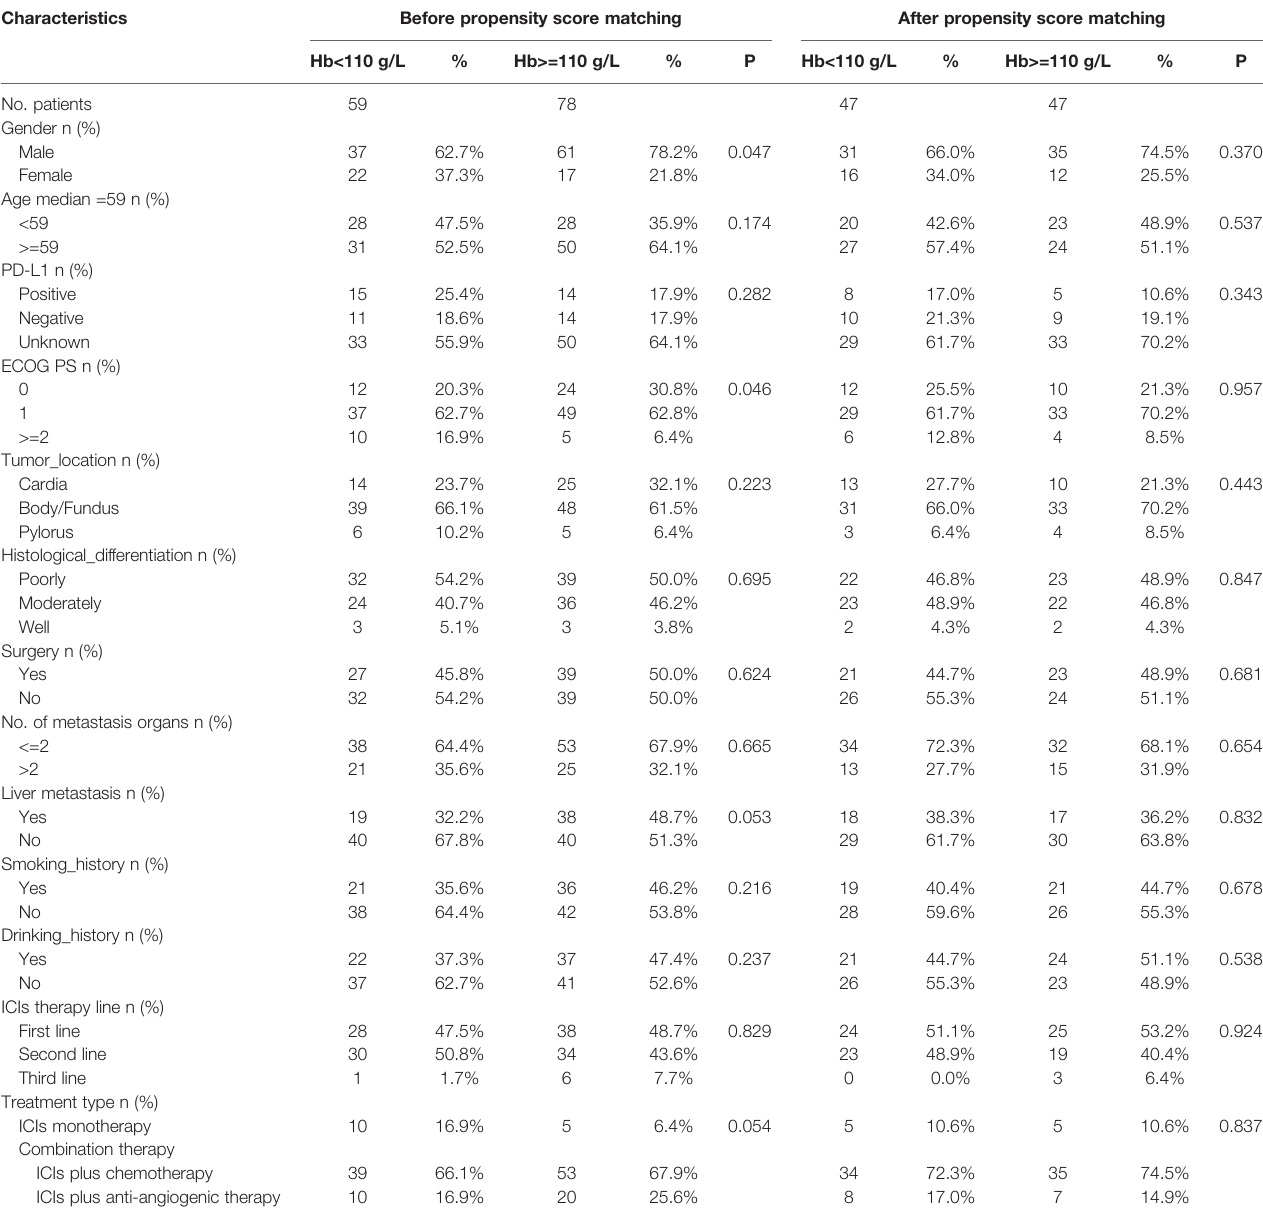
TABLE 1 | Baseline demographic characteristics of patients with AGC or MGC by Hb level before and after propensity score matching.